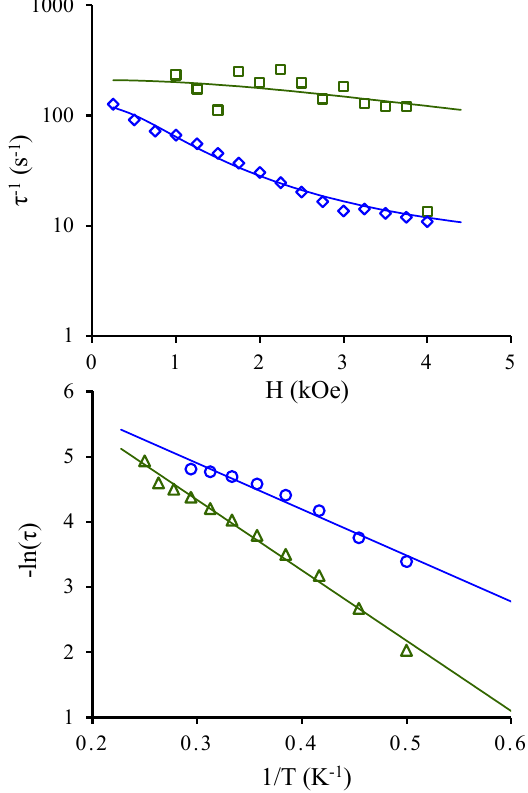
Figure 9. Field ( up ) and temperature ( down ) dependence of relaxation times for 3 DyCo and 2 DyFe . The solid lines correspond to the fit using QTM and Orbach mechanisms for the magnetic relaxa- tion.